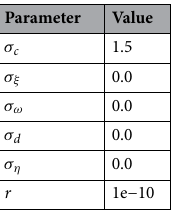
Table 3. The basic parameter